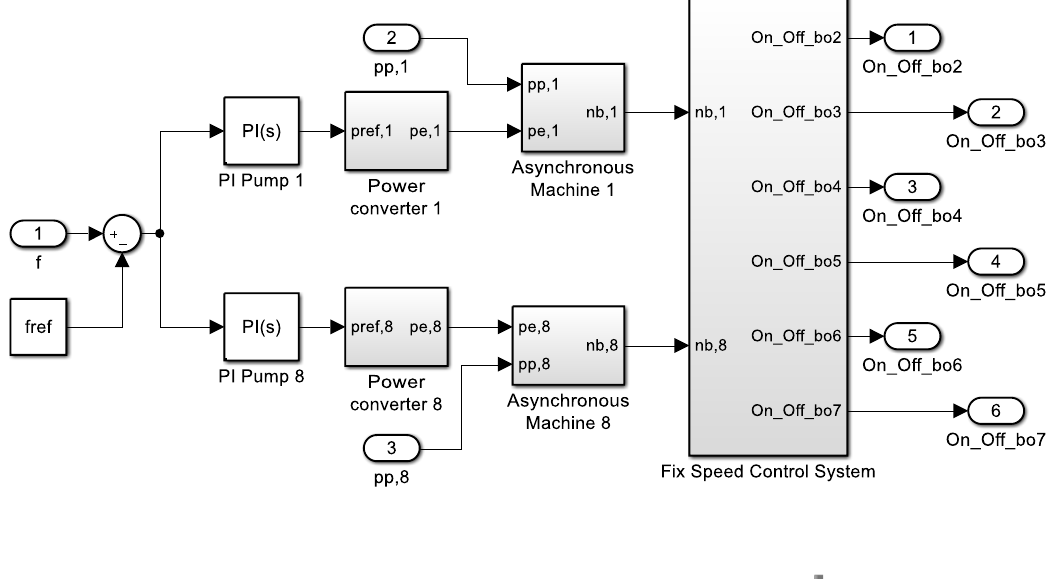
Figure 6. Variable-speed and fixed-speed control system layout.